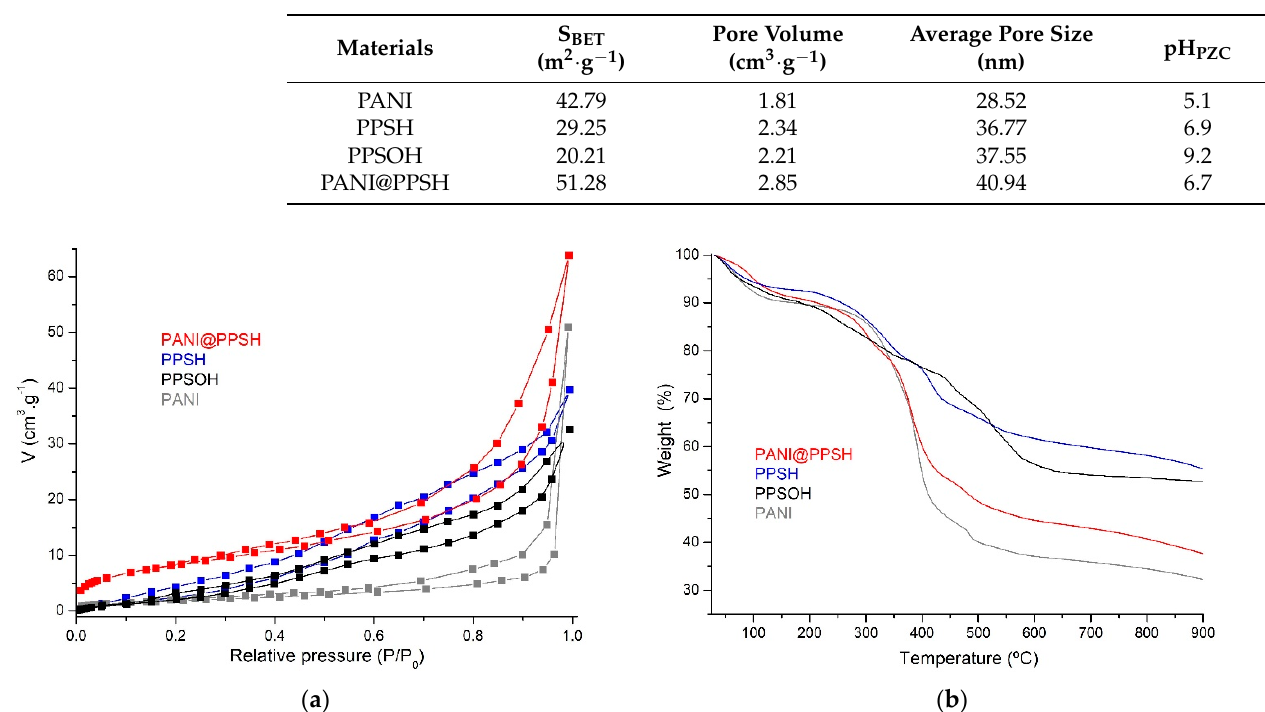
Table 1. Textural properties of adsorbents.